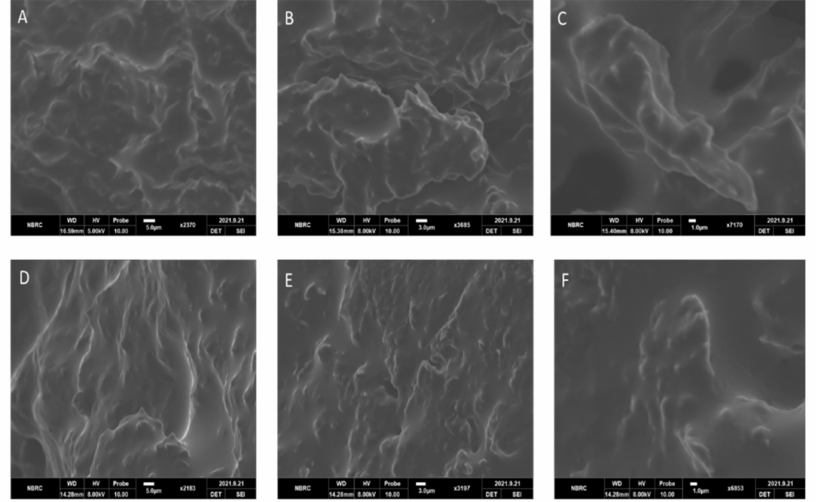
Figure 5. SEM images of drug-unloaded ( A – C ) and FLZ-loaded ( D – F ) formulations at different